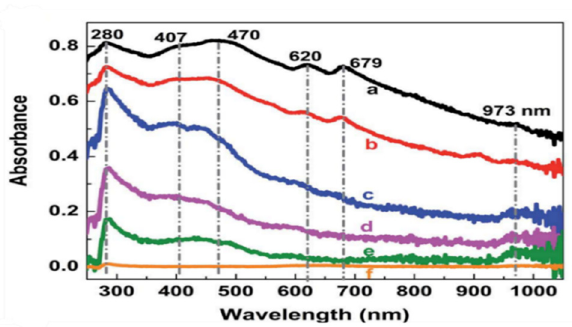
Figure 9. Broadband UV–IR absorption of layered MoS 2 /rGO nanocomposite in the wavelength range from 280 to 973 nm [27]. range from 280 to 973 nm